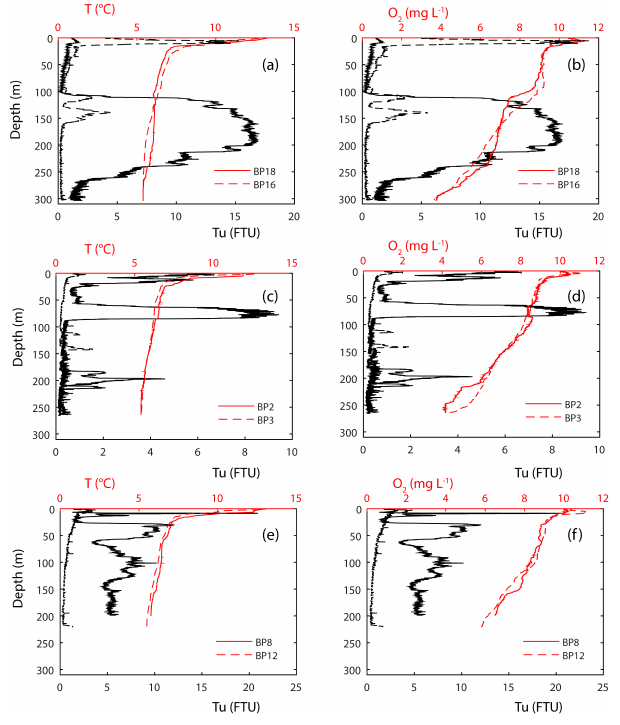
Figure 3. Comparison of temperature, turbidity, and O 2 depth pro- files for nearby stations, one being undisturbed (dotted lines), and the other highly disturbed (continuous lines) by the turbidity current of the Dranse (a, b) , the Veveyse (c, d) , and the Rhône rivers (d, e) .